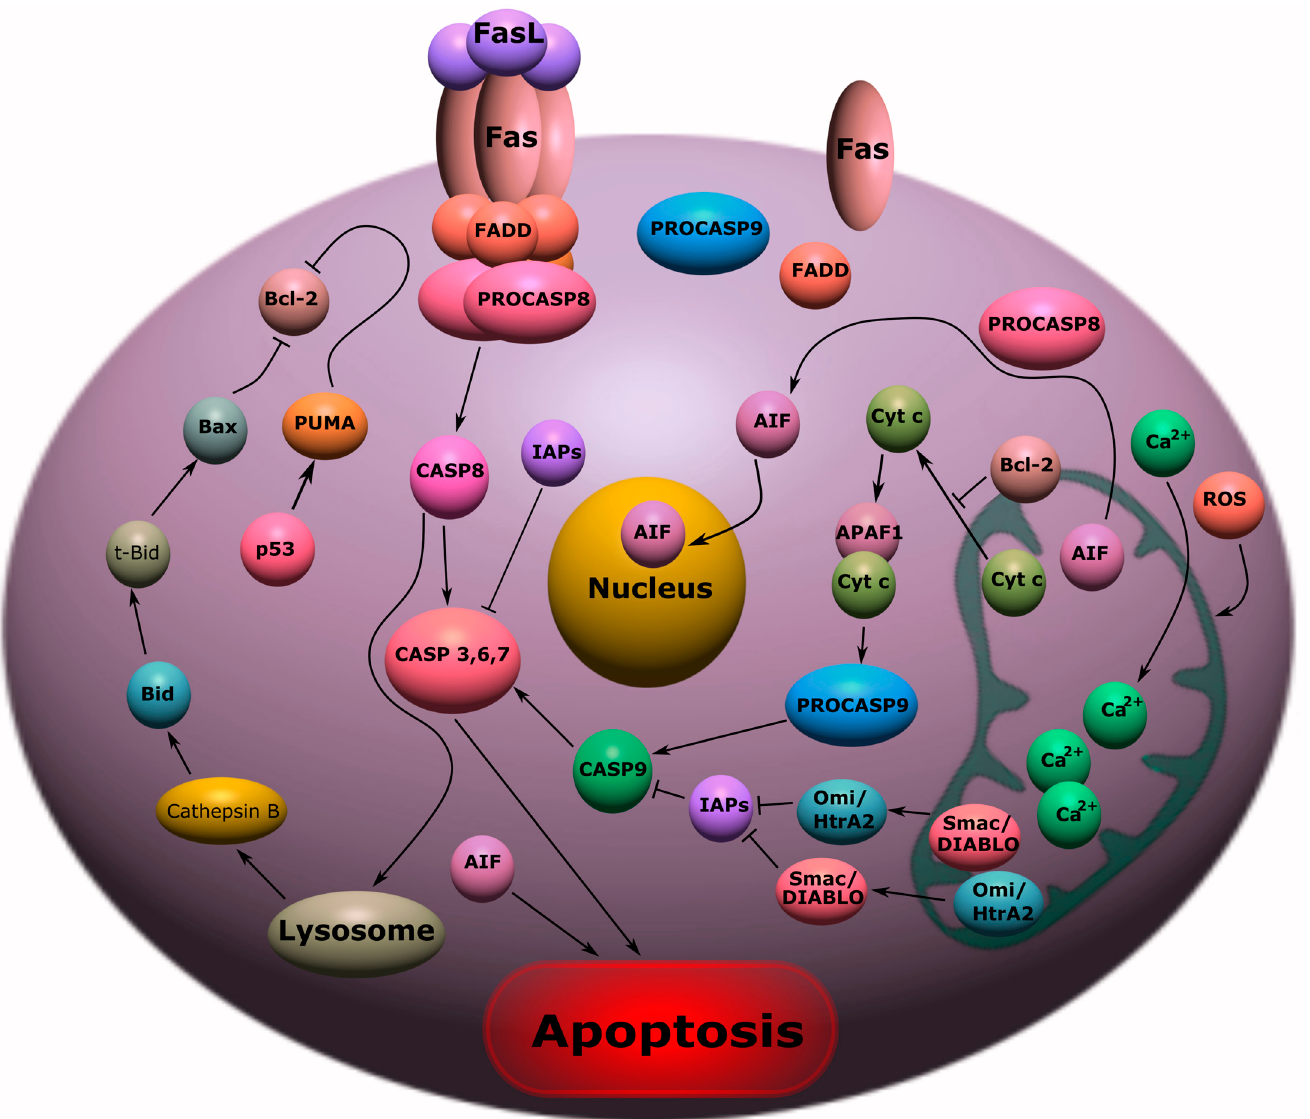
Figure 1. Signaling pathways of apoptosis: extrinsic and intrinsic pathways. Fas, death receptor; FasL, Fas ligand; FADD, Fas-associated death domain; PROCASP8, procaspase 8; PROCASP9, procaspase 9; CASP8, caspase 8; CASP9, caspase 9; CASP 3, 6, 7, caspases 3, 6, 7; Bid, BH3 interacting-domain death agonist; t-Bid, truncated Bid; Bax, bcl-2-like protein 4; Bcl-2, B-cell lymphoma 2; PUMA, p53 up-regulated modulator of apoptosis; p53, tumor suppressor protein; IAPs, inhibitor of apoptosis protein; Omi/HtrA2, mitochondrially-located serine protease; Smac/DIABLO, second mitochondria-derived activator of caspase/direct IAP Binding protein with Lowp I; Cyt c, cytochrome c; APAF1, apoptotic protease activating factor 1; AIF, apoptosis inducing factor; Ca 2+ , calcium ions; ROS, reactive oxygen species. Arrows with a sharp end—positive regulation; arrows with a blunt end—negative regulation.